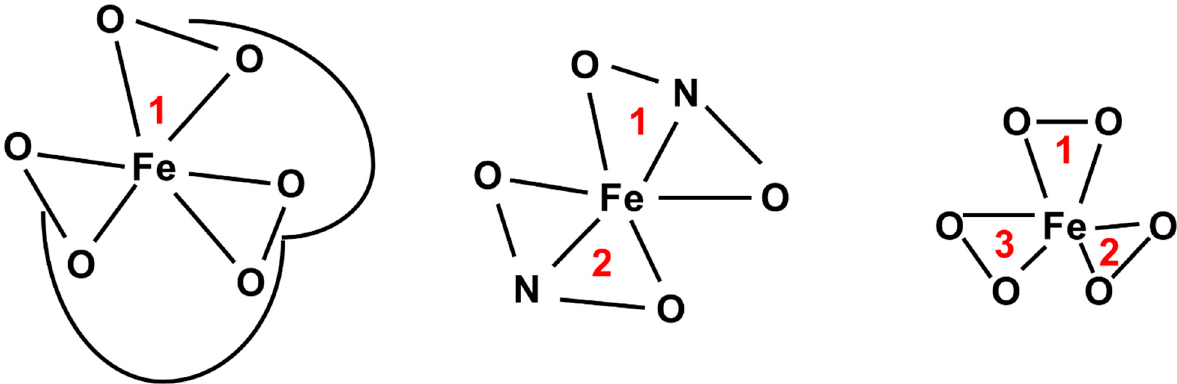
Figure 7. Structure of different Fe-chelator complexes. Hexadentate Fe–chelators (e.g., desferrioxamine) bind Fe with 1:1 stoichiometry. Tridentate chelators (e.g.,) bind Fe with 2:1 stoichiometry. Bidentate chelators (e.g.,) bind Fe with 3:1 stoichiometry.